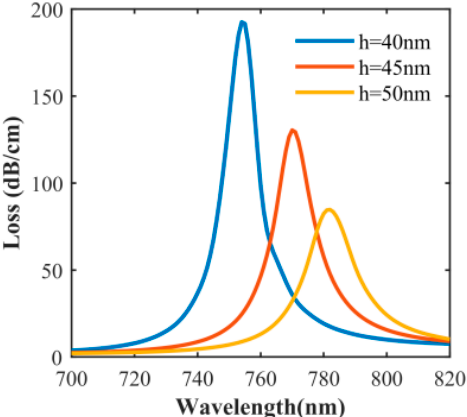
Figure 9. Influence of h Au on the loss spectrum with n a = 1.43.